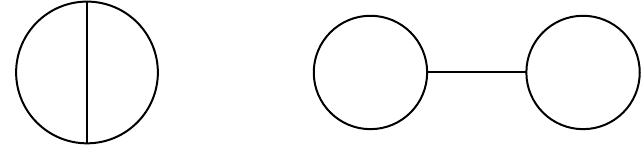
Figure 14 . Vacuum topologies at two